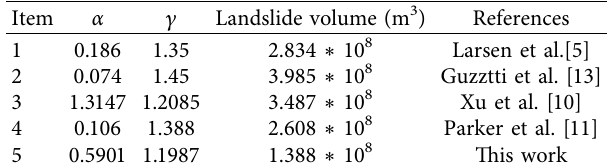
Table 1: Calculated landslide volumes using V-A relation with different